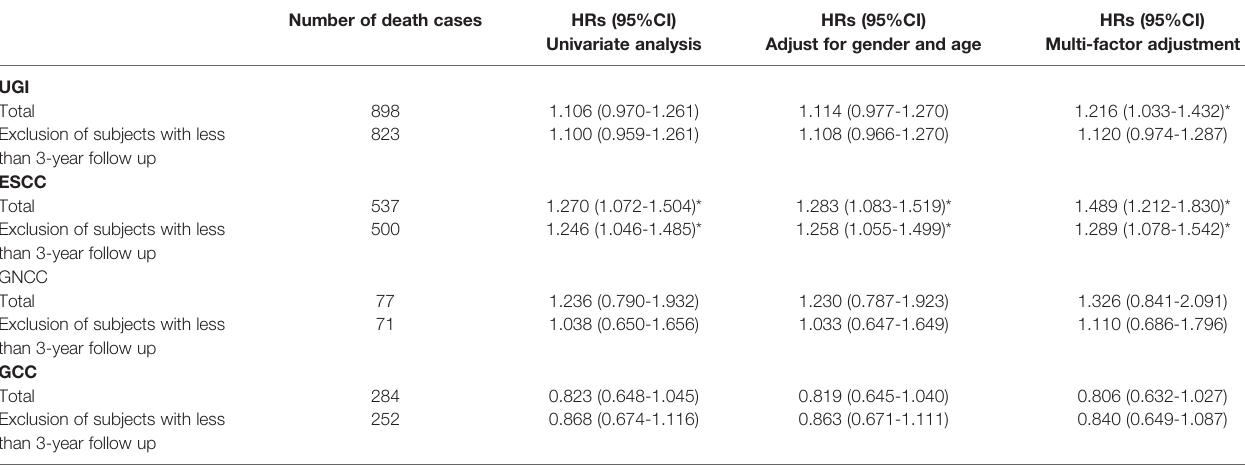
TABLE 5 | Results of sensitivity